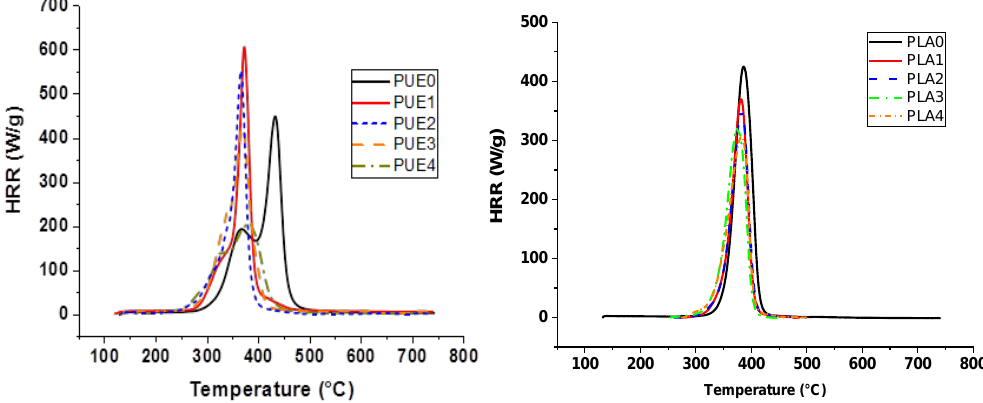
Figure 9. PCFC curves for PUE/APP/S9 and PLA/APP/S9 composites. Table 4. PCFC results for PUE/APP and PLA/APP composites.